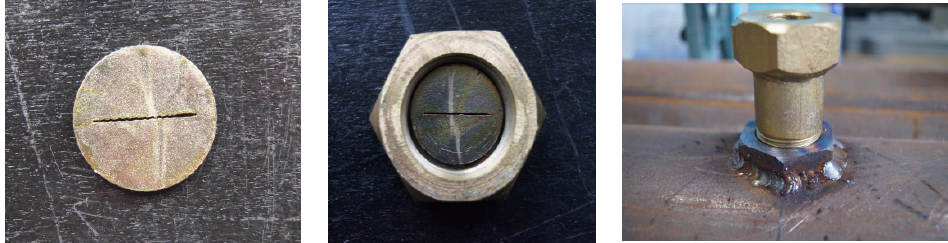
Figure 2. Pipeline defect model and method for fixing it.